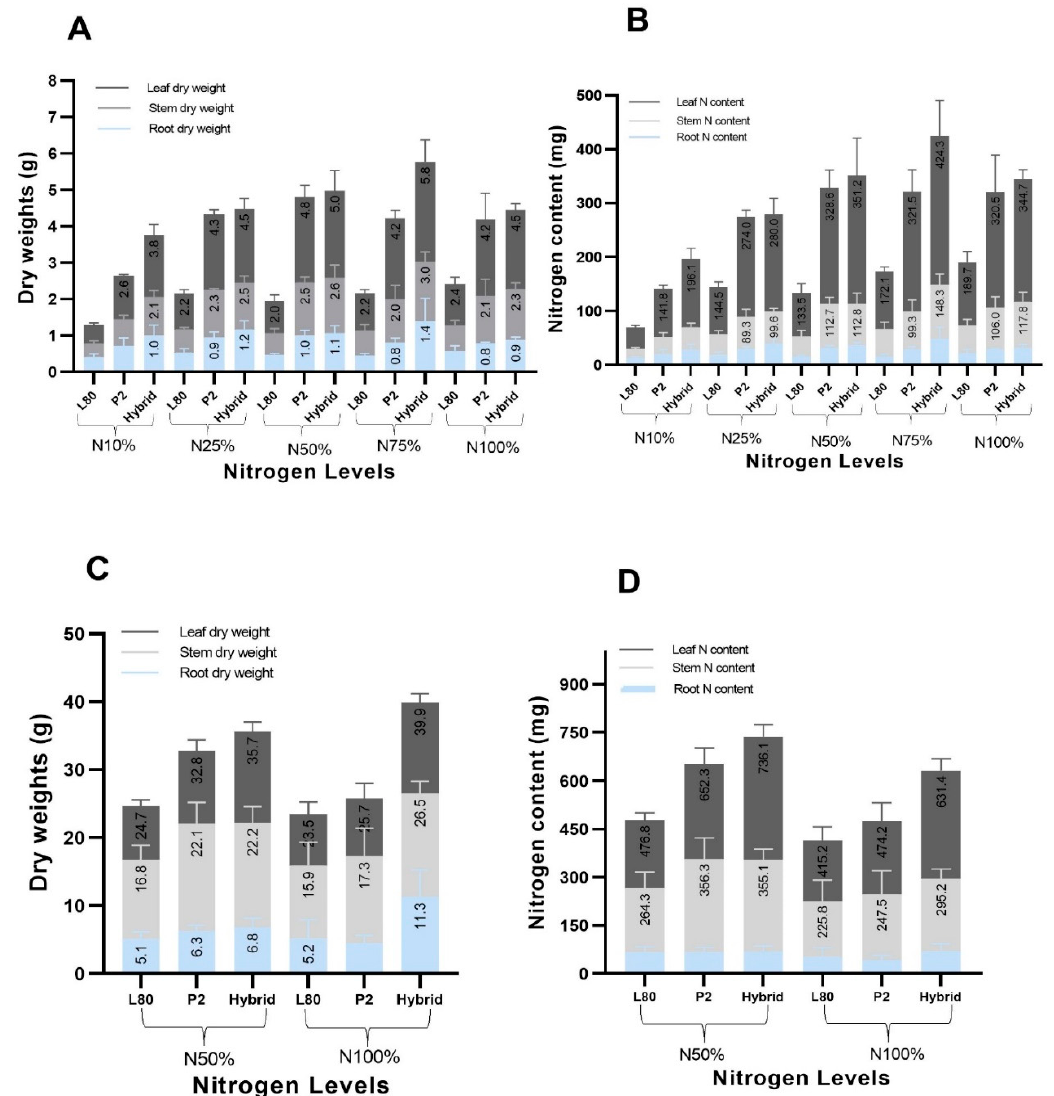
Figure 1. Comparison of the leaf, stem, root dry weight ( A ), N content ( B ) at the V6 stage, leaf and stem, root dry weight ( C ) and N content ( D ) at the VT stage of the popcorn genotypes under different N levels.